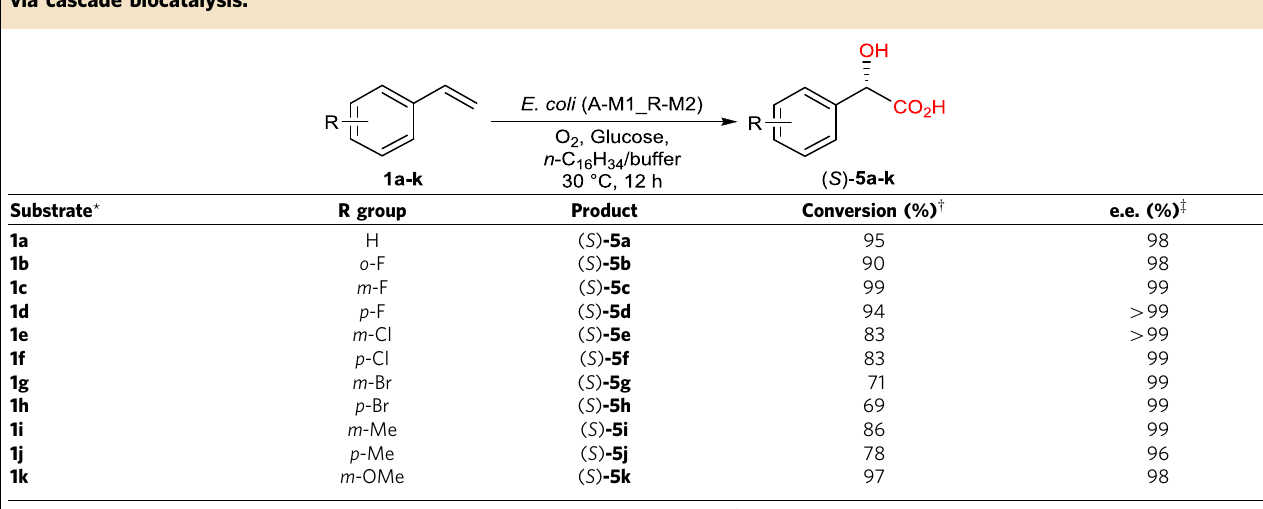
Table 2 | Regio- and enantioselective functionalization of terminal alkenes 1a–k to a -hydroxy acids 5a–k with E. coli (A-M1_R-M2) via cascade biocatalysis.